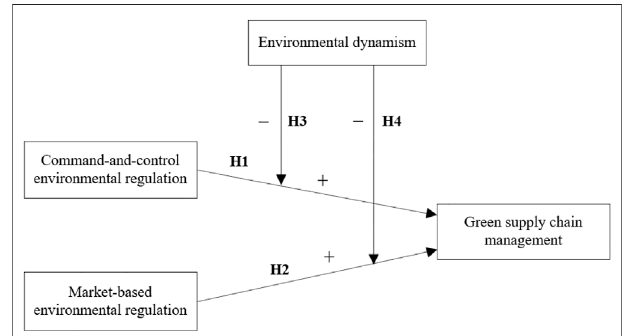
FIGURE 1 | Our theoretical model.